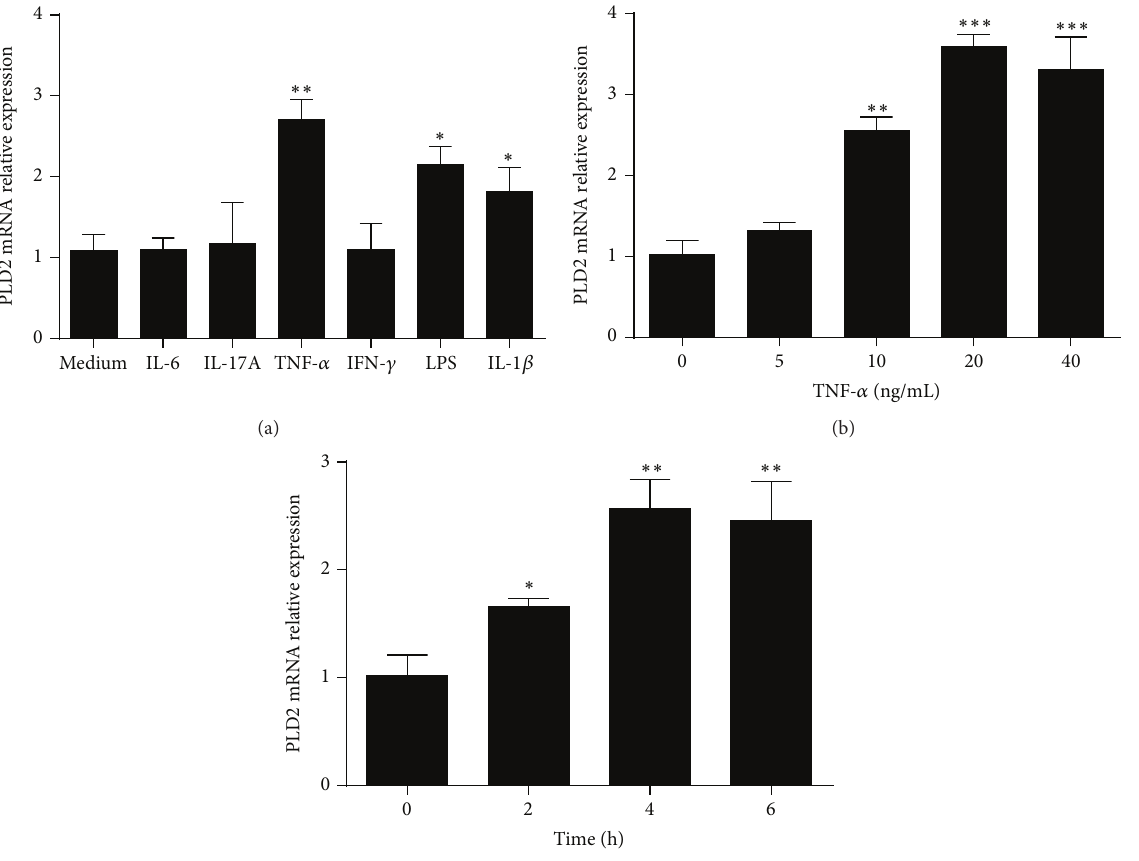
Figure3:TNF- 𝛼 upregulatesPLD2expressioninneutrophils.(a)Neutrophilsisolatedfromhealthydonors( 𝑛 = 10 )werestimulatedwithIL-6 (10ng/mL), IL-17A (10ng/mL), TNF- 𝛼 (10ng/mL), IFN- 𝛾 (10ng/mL), LPS (10ng/mL), and IL-1 𝛽 (10ng/mL), respectively, for 4h. Expression of PLD2 mRNA was detected by qRT-PCR. ∗ 𝑝 < 0.05 , ∗∗ 𝑝 < 0.001 , and ∗∗∗ 𝑝 < 0.01 versus medium alone. (b) Neutrophils isolated from healthy donors ( 𝑛 = 10 ) were stimulated in vitro with different concentrations of TNF- 𝛼 as indicated for 4 h; expression of PLD2 was detected by qRT-PCR. ∗ 𝑝 < 0.05 , ∗∗ 𝑝 < 0.01 , and ∗∗∗ 𝑝 < 0.001 versus that under culture in medium alone. (c) Neutrophils isolated from healthy donors ( 𝑛 = 10 ) were stimulated with TNF- 𝛼 (10ng/mL) for 2, 4, and 6 h, and expression of PLD2 was detected by qRT-PCR. ∗ 𝑝 < 0.05 , ∗∗ 𝑝 < 0.01 , and ∗∗∗ 𝑝 < 0.001 versus that at the beginning of stimulation. Gene expression was normalized to GAPDH in each